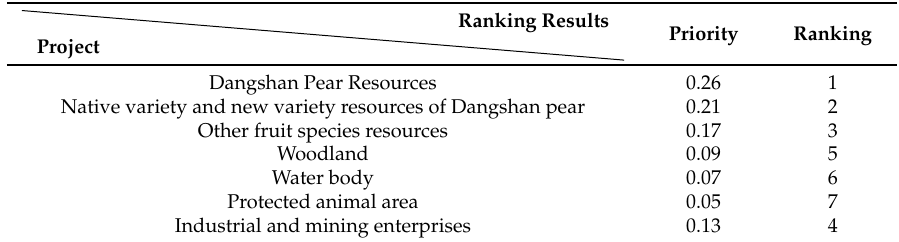
Table 7. Ranking results of farmers’